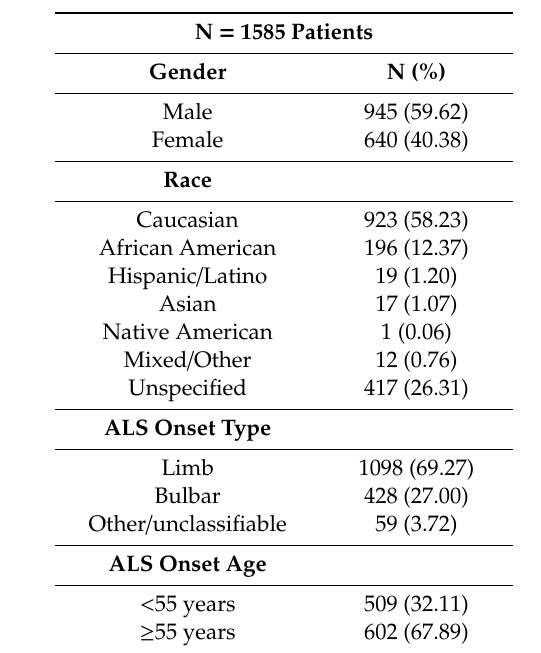
Table 1. Overall cohort characteristics for biological gender, race, ALS onset type, and ALS onset